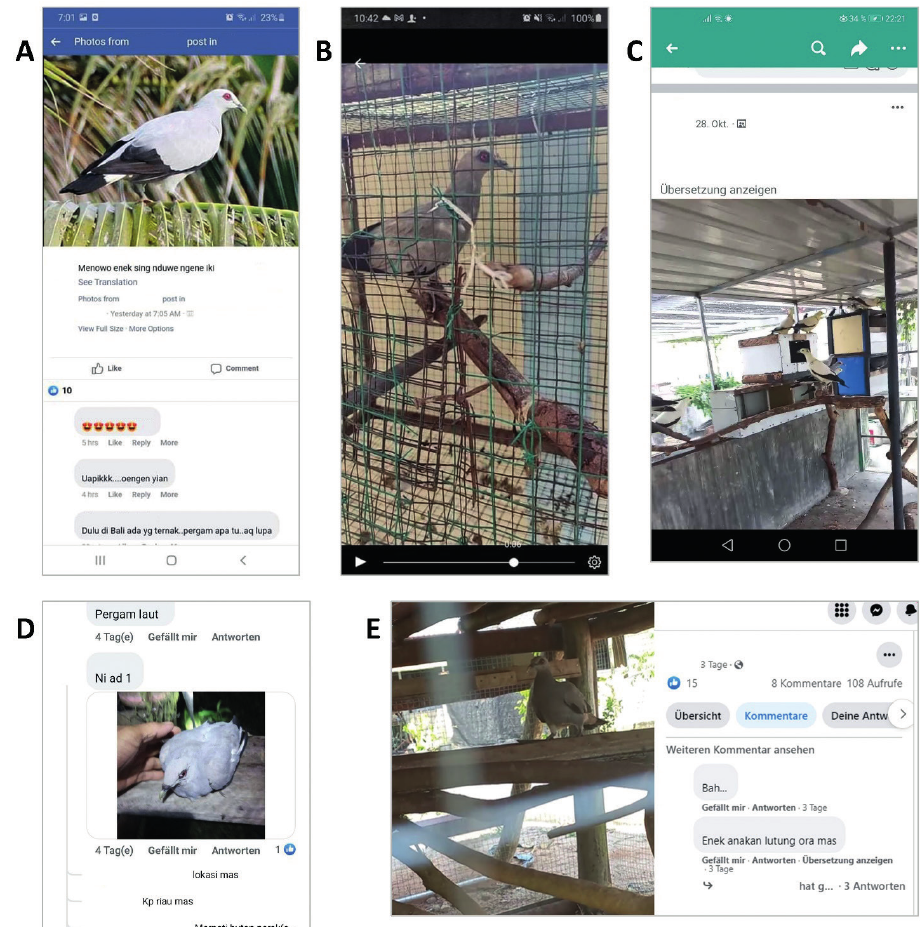
Figure 1. Screenshots of social media posts offering silvery pigeons between October and December 2021 A initial post discovered B screenshot of a video provided by a seller from Padang (province of West Sumatra) showing one of the two silvery pigeons from the initial post (1A) C screenshot of one of two videos posted by a seller in Bintan island (Riau archipelago, Indonesia); the videos from this setting are poor in quality and show 7‒10 silvery pigeons in a cage with a larger group of pied imperial pigeons and one green imperial pigeon D image from a comment to the initial post (1A), from Singkep island (Lingga archipelago, Indonesia), showing an additional silvery pigeon. A further video posted by this person shows a single silvery pigeon with a larger group of pied imperial pigeons in a cage, potentially the same bird as in 1D (see Suppl. material 1–4) E screenshot of a video posted in December 2021 showing a single silvery pigeon with a group of green imperial pigeons and three pied imperial pigeons in a cage in Bintan island posted by the same person as in 1C but seem to be in a different setting (see Suppl. material